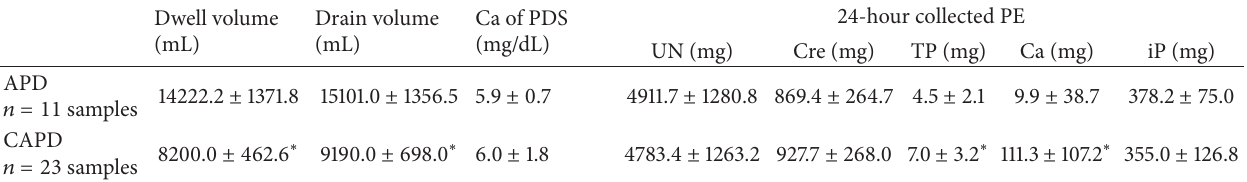
24-hour collected PE